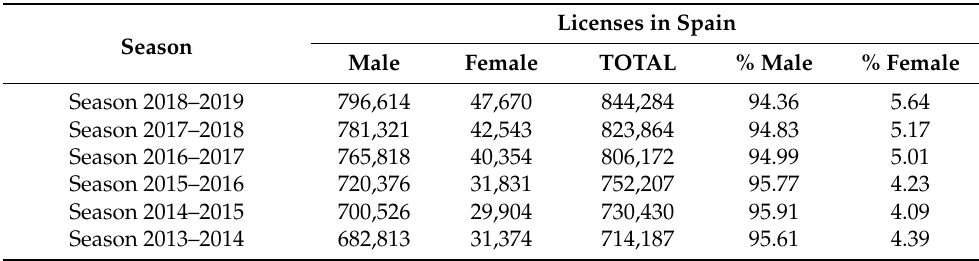
Table 4. Football and indoor football sports licenses in Spain during the last four seasons, organized by gender.